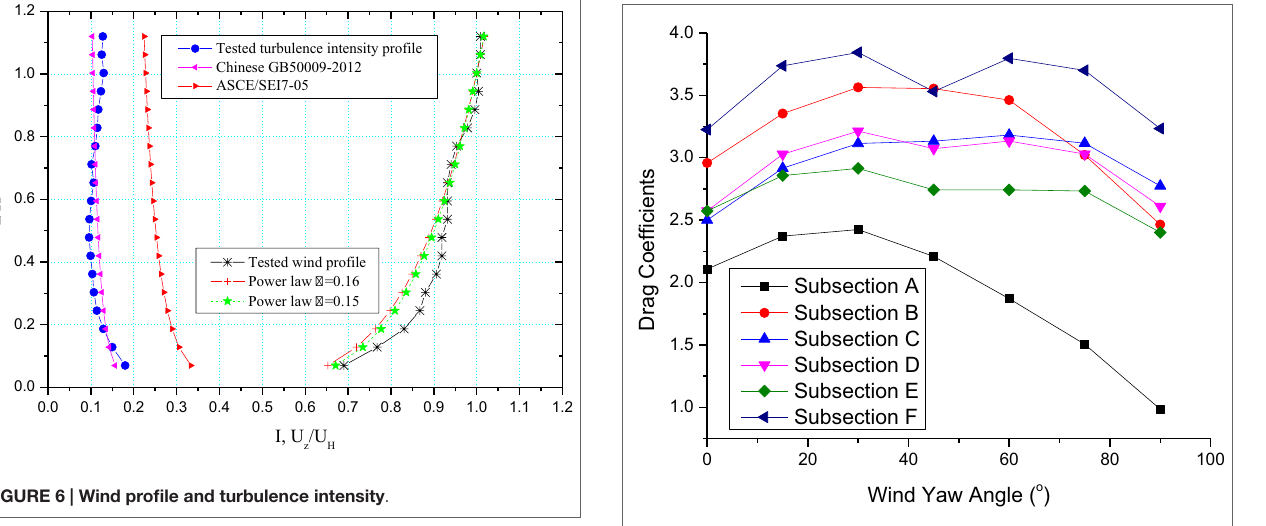
FigUre 8 | Drag coefficients for subsections .